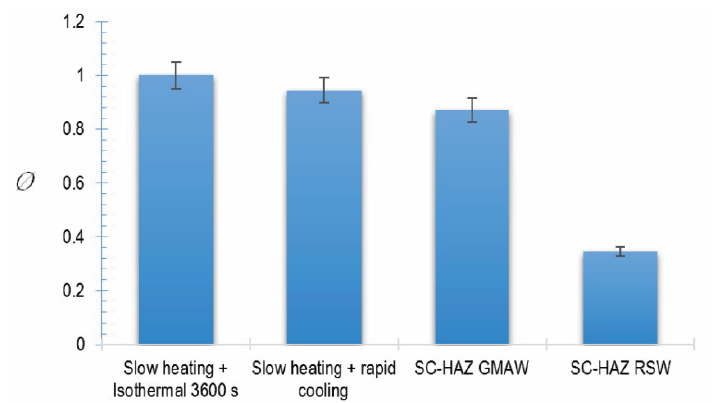
Figure 9. Softening progression in tempered martensite islands upon different conditions.